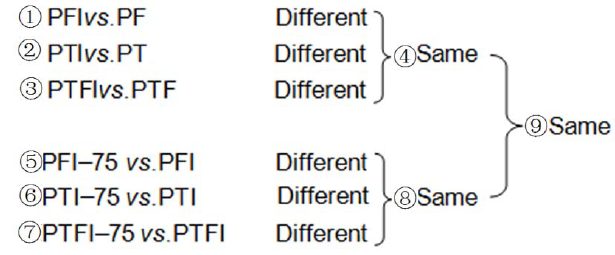
Figure 1. The comparative scheme of the miRNA related to PaWB.